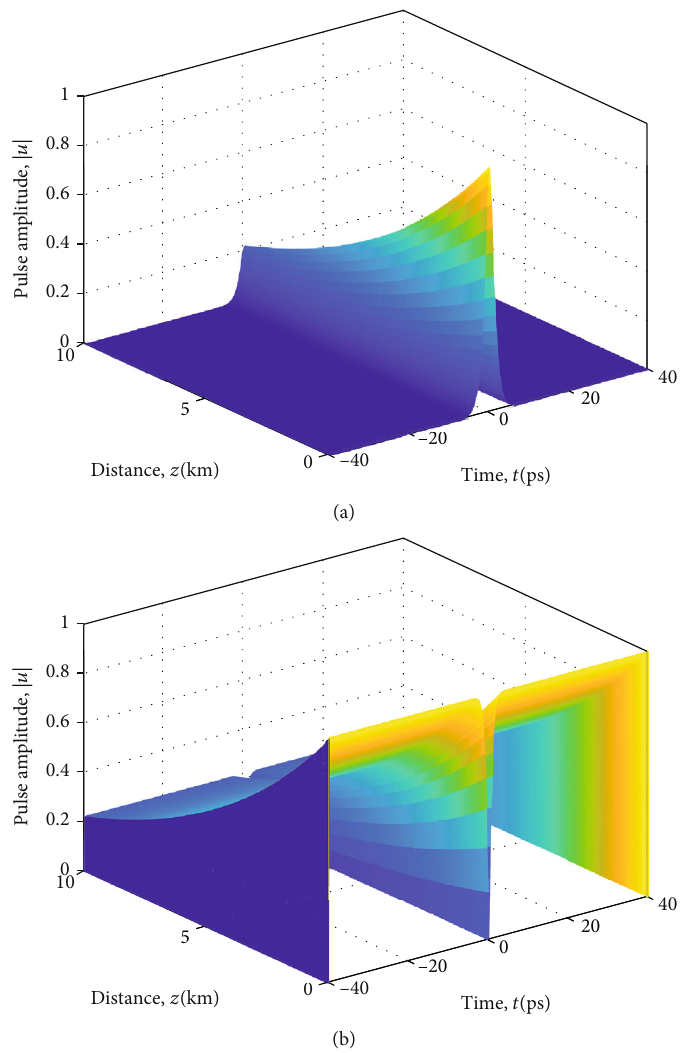
Figure 10: Three-dimension graphs of the split-step Fourier transform (SSFT) approximate solution for a lossy optical fi ber α = 0 : 3 dB/km when the input pulse is a bright soliton (a) and a black dark soliton (b), respectively, at a distance z = 10